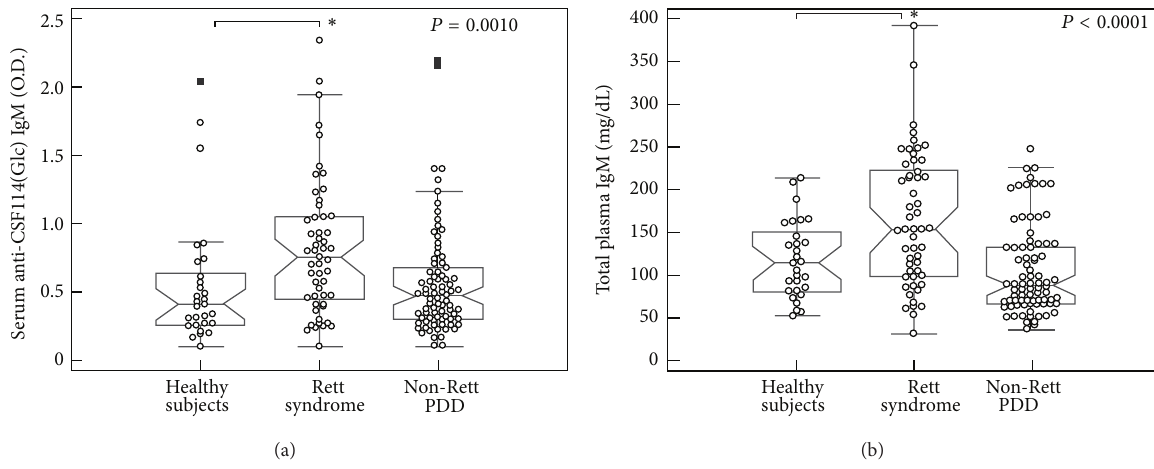
Figure 1: Elevated autoantibodies anti-CSF114(Glc) and total IgM titers in Rett syndrome. (a) Anti-CSF114(Glc) serum IgM antibody titers by the N -glucopeptide-based immunoenzymatic assay: comparison between RTT and non-RTT PDD patients. (b) Total plasma IgM levels detectedbytheconventionalagglutinationassay(RocheCobas6000).Dataareplottedasnotchedboxdotplotswithmediansandinterquartile range values. 𝑃 values refer to nonparametric Kruskal-Wallis analysis of variance. Solid rectangles indicate outlier values, ∗ 𝑃 < 0.05 .